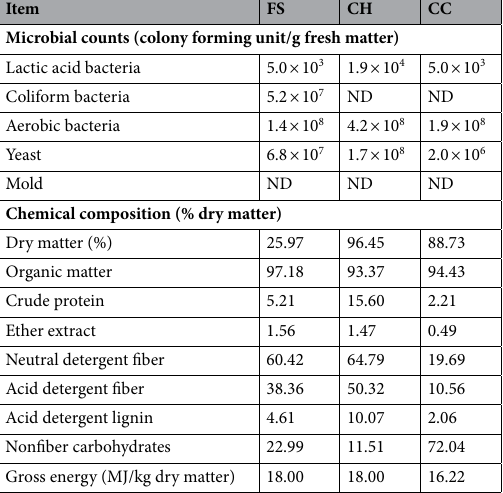
Table 1. Microbial counts, chemical composition and gross energy content of the ensiling materials used in this study. FS forage sorghum, CH Cavalcade hay, CC cassava chip, ND not